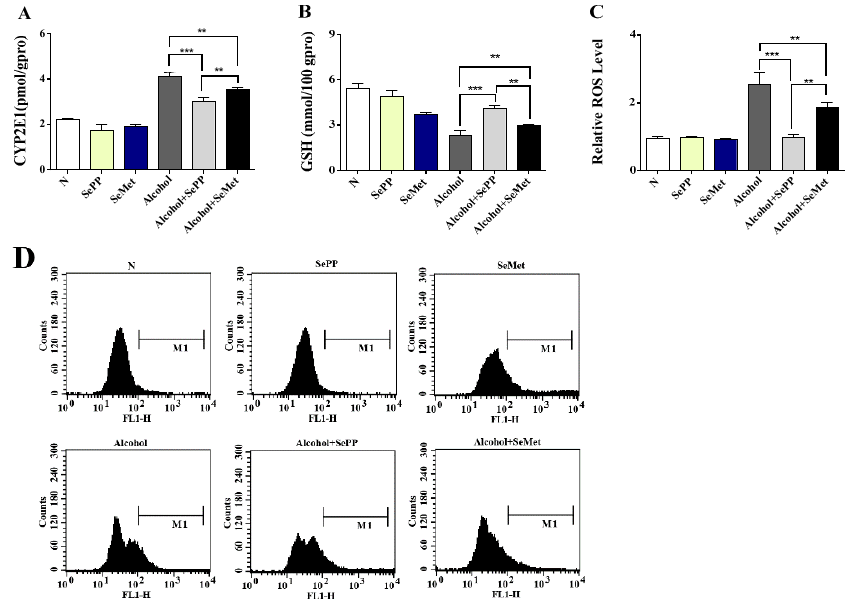
Figure 3. Effects of SePP and SeMet on alcohol-induced increase in oxidative stress in a cell culture model. Effects of alcohol and selenium compounds on CYP2E1 activity ( A ), mitochondrial GSH content ( B ), and relative ROS level ( C ), flow cytometry peak diagram of ROS level ( D ). ** p < 0.01, *** p < 0.001